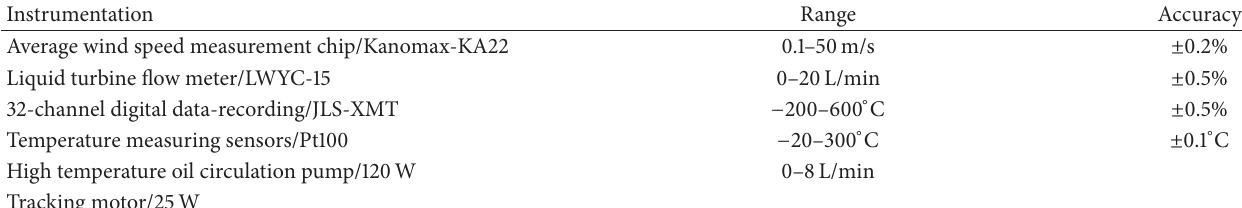
Table 1: Technical specifications of instruments used in experimental setup.